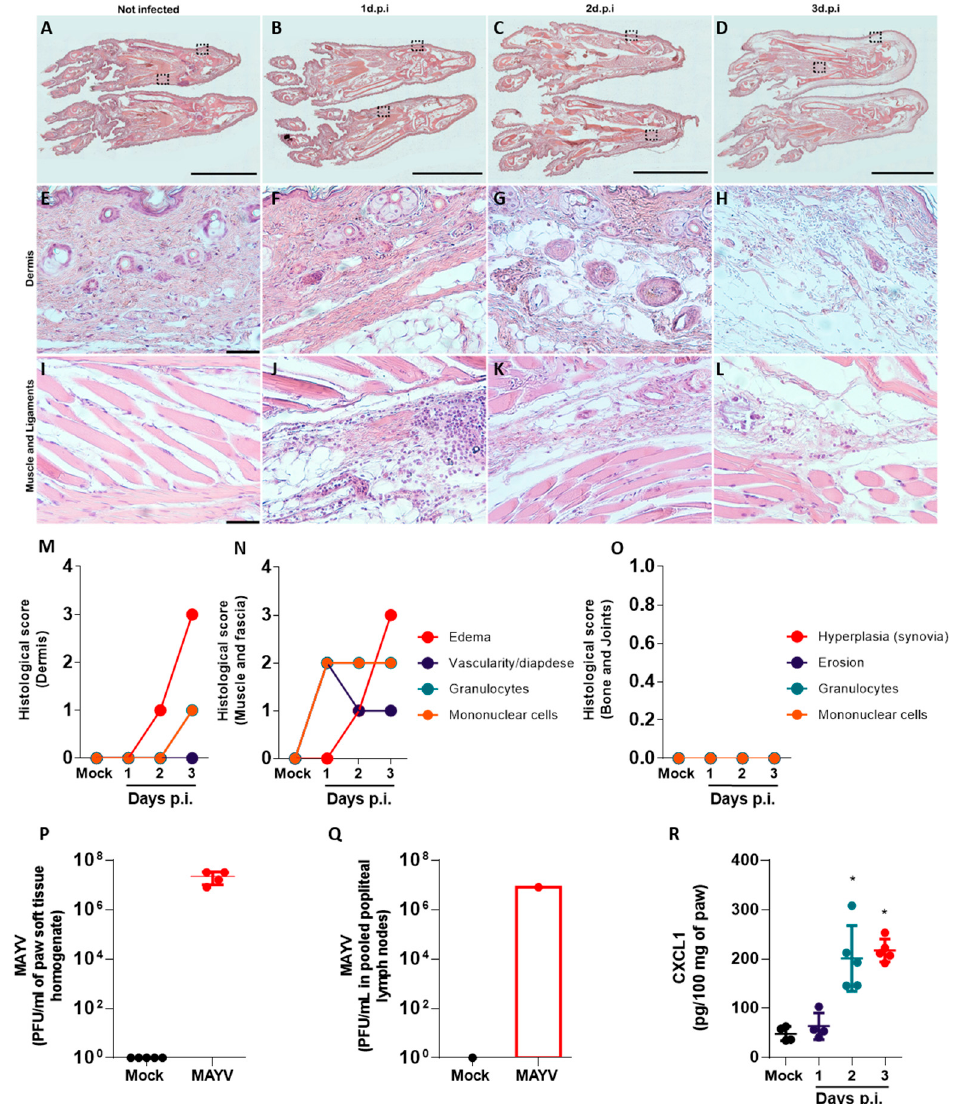
Figure 3. Paw inflammation in MAYV-infected mice involves edema in multiple tissues, local production of chemokine, leukocyte recruitment and infection. Representative photomicrographs of longitudinal footpad sections of mock- and MAYV-infected mice at days 1 to 3 p.i. stained with hematoxylin–eosin, showing ( A – D ) overview of the footpad and 20 × magnified images of ( E – H ) skin and ( I – L ) muscles and ligaments. ( M – O ) Histological scores were established to evaluate edema, vascularity, diapedesis and cell infiltration in ( M ) skin, ( N ) muscle and ligaments, and ( O ) bone and joint in the footpad sections. MAYV viral load in ( P ) hind paws and ( Q ) in popliteal lymph nodes, and ( R ) CXCL1 levels in hind paws were also assessed in mock- and MAYV-infected mice at day 3 p.i. Data presented as mean ± SEM. * p ≤ 0.05. Scale bar ( A – D ) 5 mm; ( E – L ) 50 µ